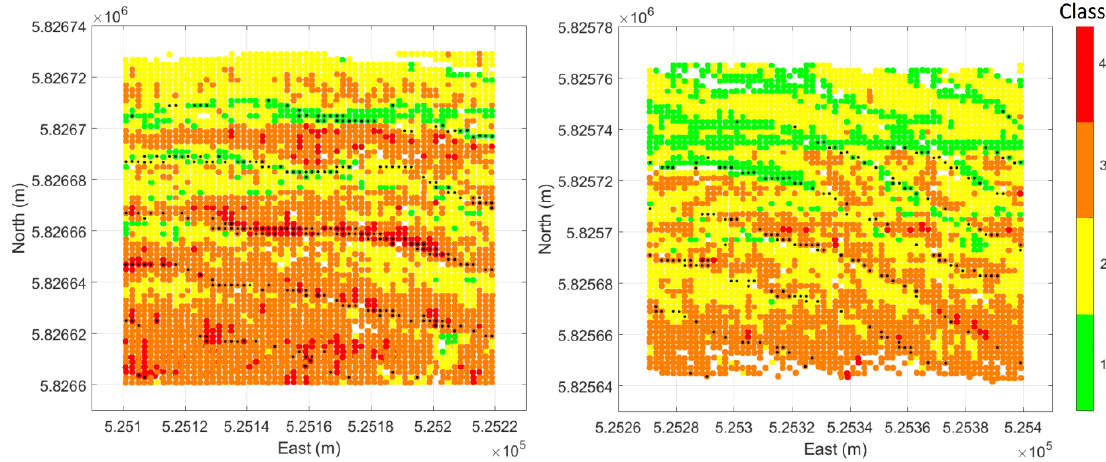
Figure 19. Acoustic classification results in two typical areas of Figure 16. Black dots indicate steep slopes of < − 10 ◦ on the lee side of megaripples.